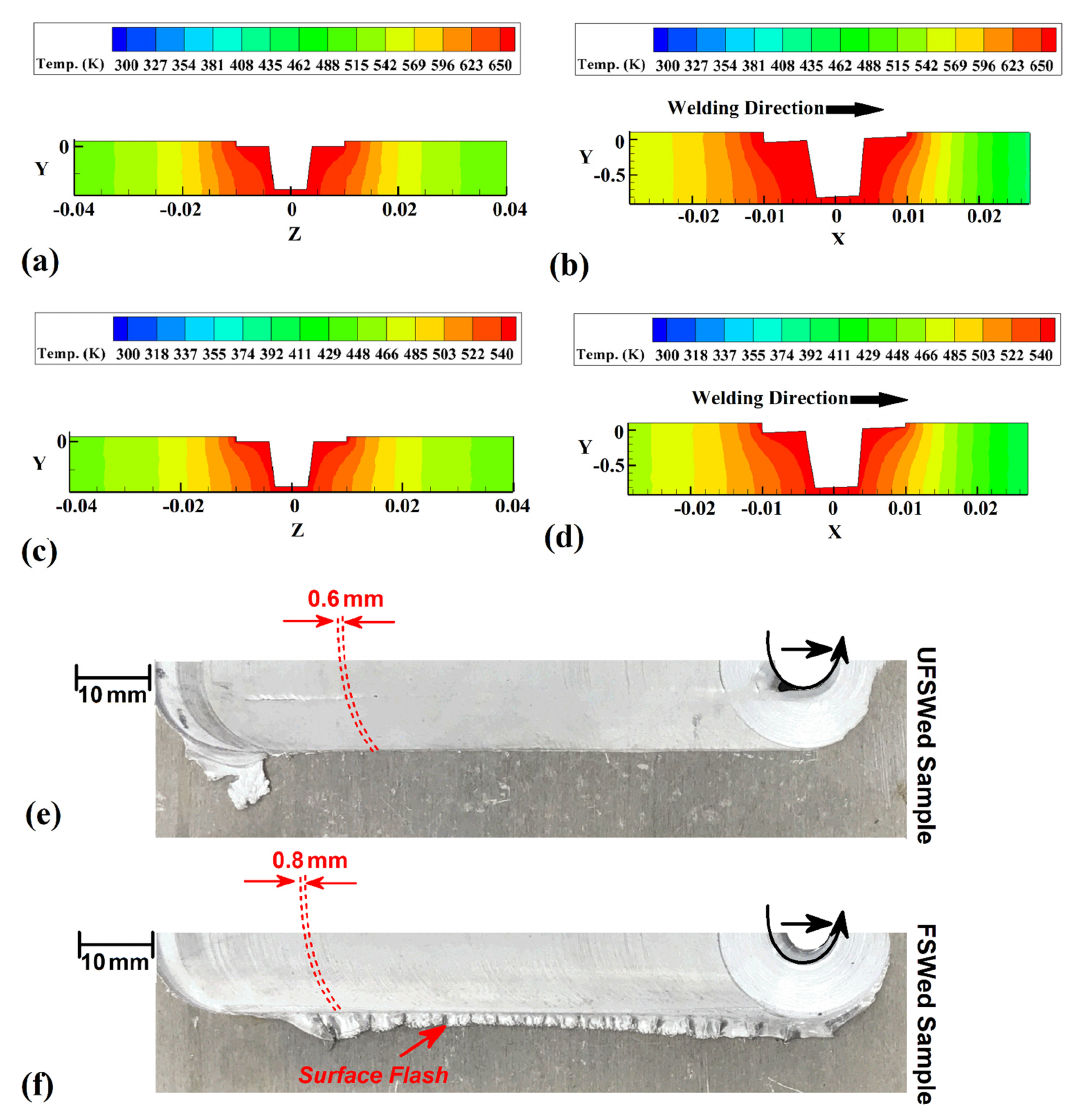
Figure 5. ( a ) cross-section and ( b ) longitudinal-section simulation results of internal heat flux of FSW sample. ( c ) Cross-section and ( d ) longitudinal-section simulation results of internal heat flux of UFSW sample. Surface materials flow of ( e ) UFSW and ( f ) FSW joint line.